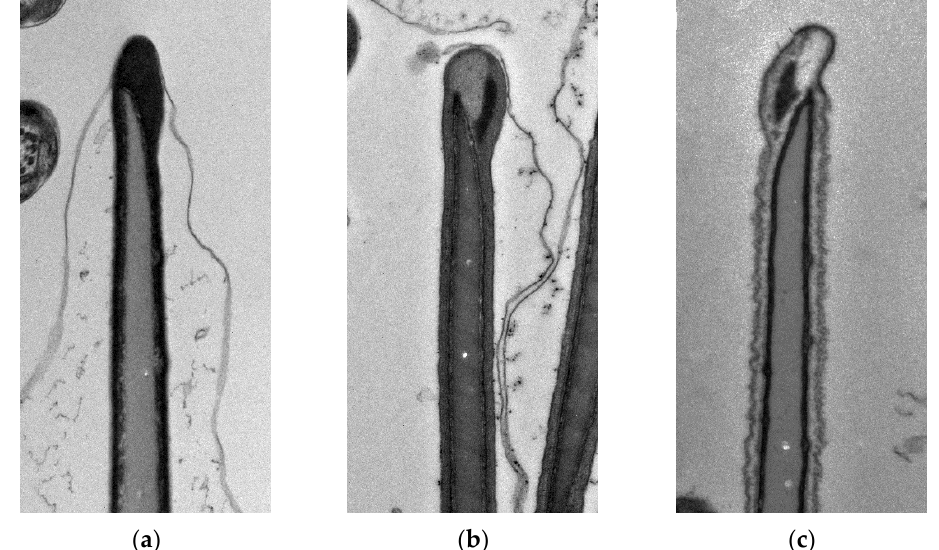
Figure 2. Sperm quality classes according to the state of plasma membrane. ( a ) intact acrosome, ( b ) swollen acrosome, and ( c ) damaged plasma membrane and released acrosome content.